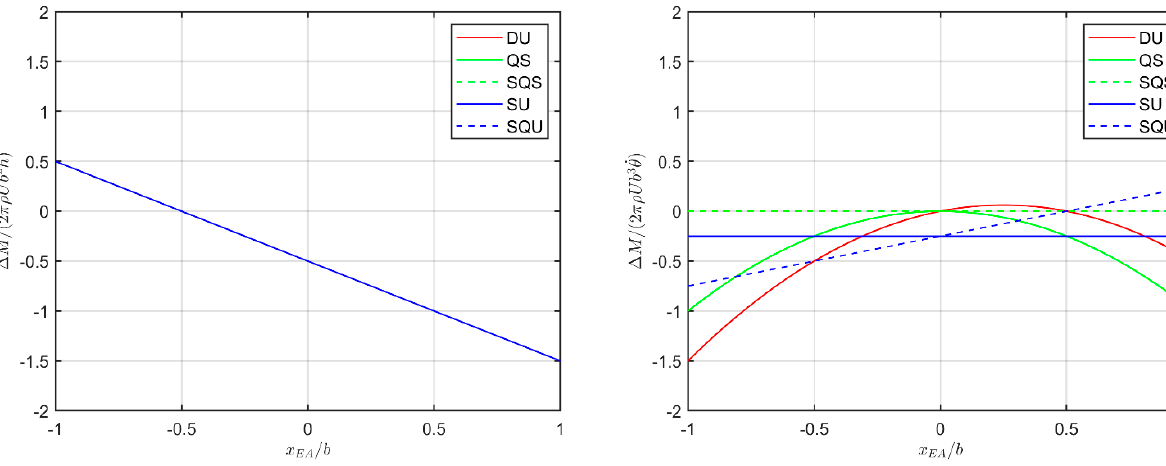
Figure 2. Normalised aerodynamic damping derivatives for the aerofoil’s moment: plunge rate ( left ), pitch rate ( right ).